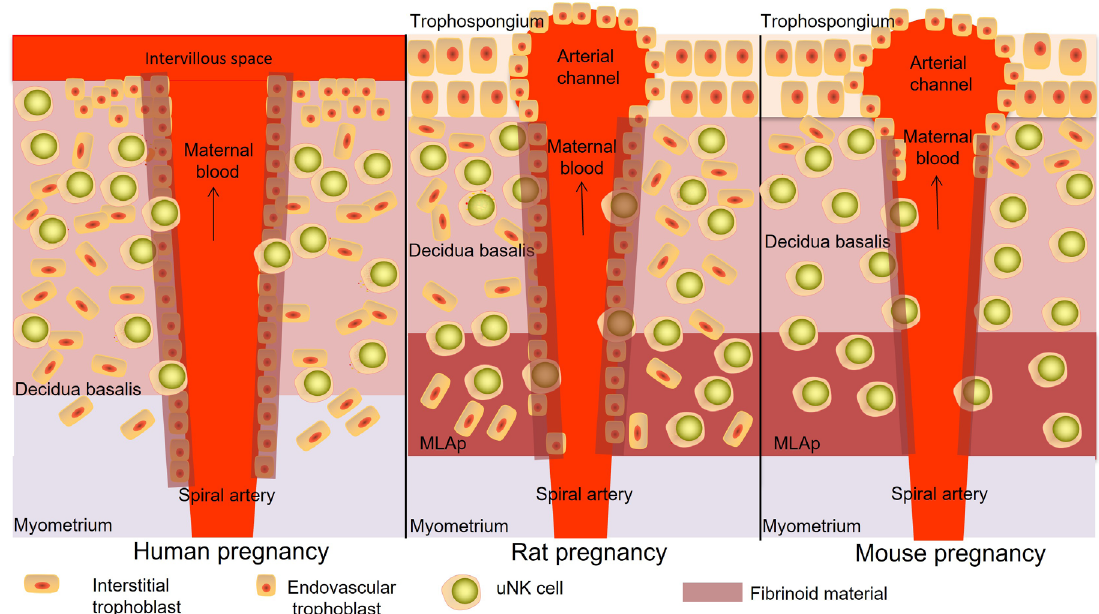
Figure 1. Location of uNK cells in the placenta of early to mid-pregnancy of humans (left), rats (middle) and mice (right). In mice and rats, uNK cells can be found in the decidua basalis and mesometrial lymphoid aggregate of pregnancy (MLAp). They can be found close to trophoblast cells, around the spiral arteries and in the arterial wall as well as scattered throughout the decidua and MLAp. In mice, trophoblast invasion is only seen in the first part of the decidua, close to the trophospongium, while in rats, trophoblast invades throughout the whole decidua and into the MLAp. In the human placenta, uNK cells can be found in the decidua basalis, closely related to trophoblast cells, around and in the wall of the spiral arteries as well as scattered throughout the decidua. In human, rat and mouse placentas also other immune cells can be found, such as macrophages, dendritic cells and T cells (not shown in this figure) Note. Adapted from “Uterine NK cells and macrophages in pregnancy,” by Faas MM, de Vos P. Placenta. 2017;56:44–52